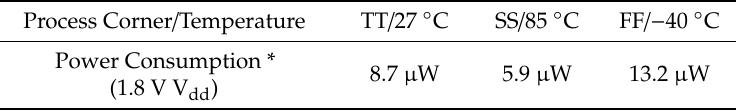
Table 2. Performance summary of the proposed demodulator.